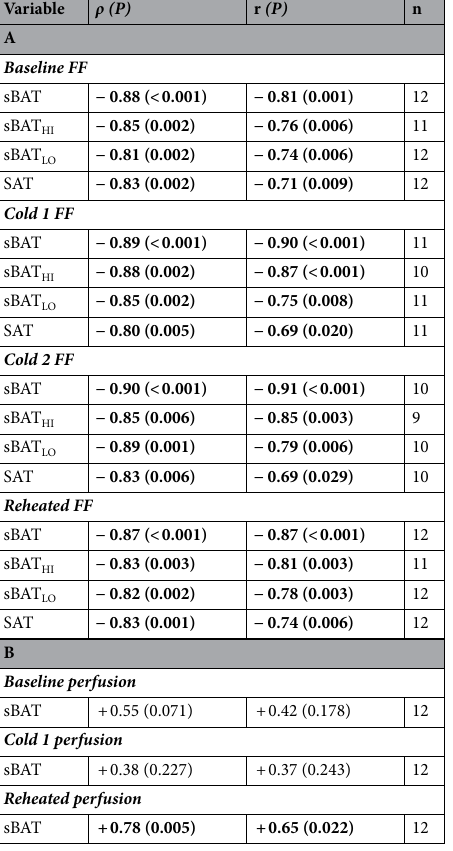
Table 2. Correlation between MR glu and (A) FF and (B) perfusion, during the Cooling-reheating protocol. Correlation of measurements estimated within the same segmentation. ρ, Spearman rank-order correlation